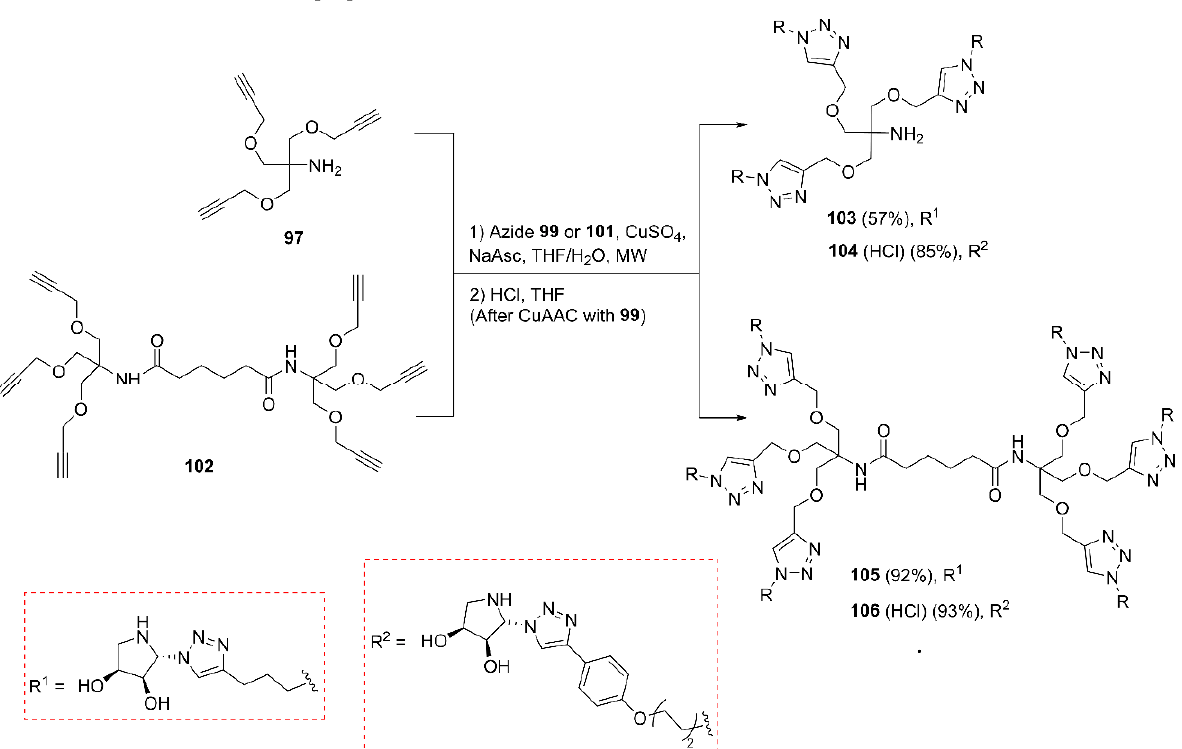
Scheme 19 . Synthesis of multivalent iminosugars 103 – 106 . Scheme 19. Synthesis of multivalent iminosugars 103 – 106 .